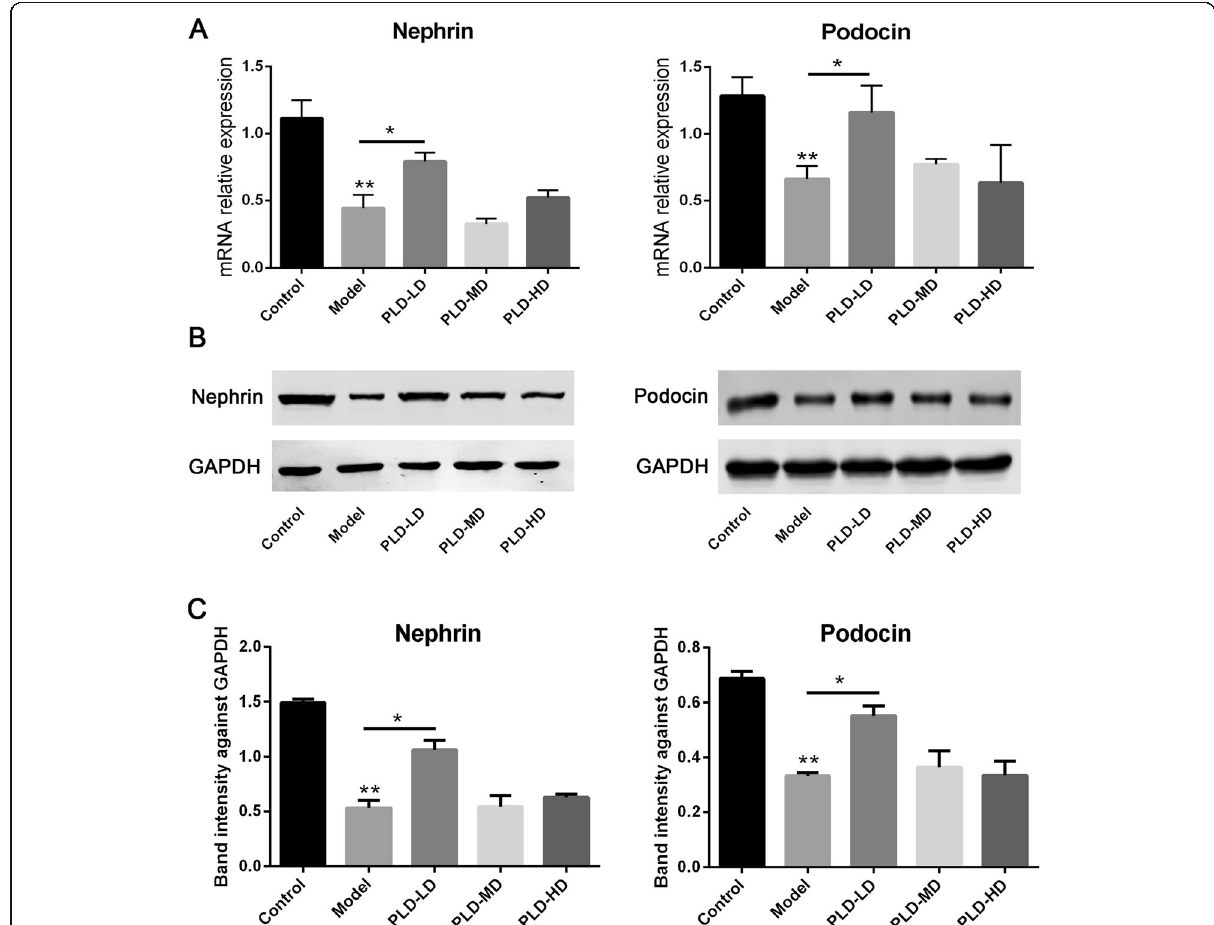
Fig. 5 Analysis of the expression of nephrin and podocin. a The mRNA expressions of nephrin and podocin in the rat kidney tissues were determined by qRT-PCR. The relative gene expression was normalized to that of GAPDH. Quantitative data are shown as the mean ± SD. * p < 0.05; ** p < 0.01. b Representative western blot of nephrin and podocin in the rat kidney tissues. c Relative protein level was calculated by band intensity against GAPDH,